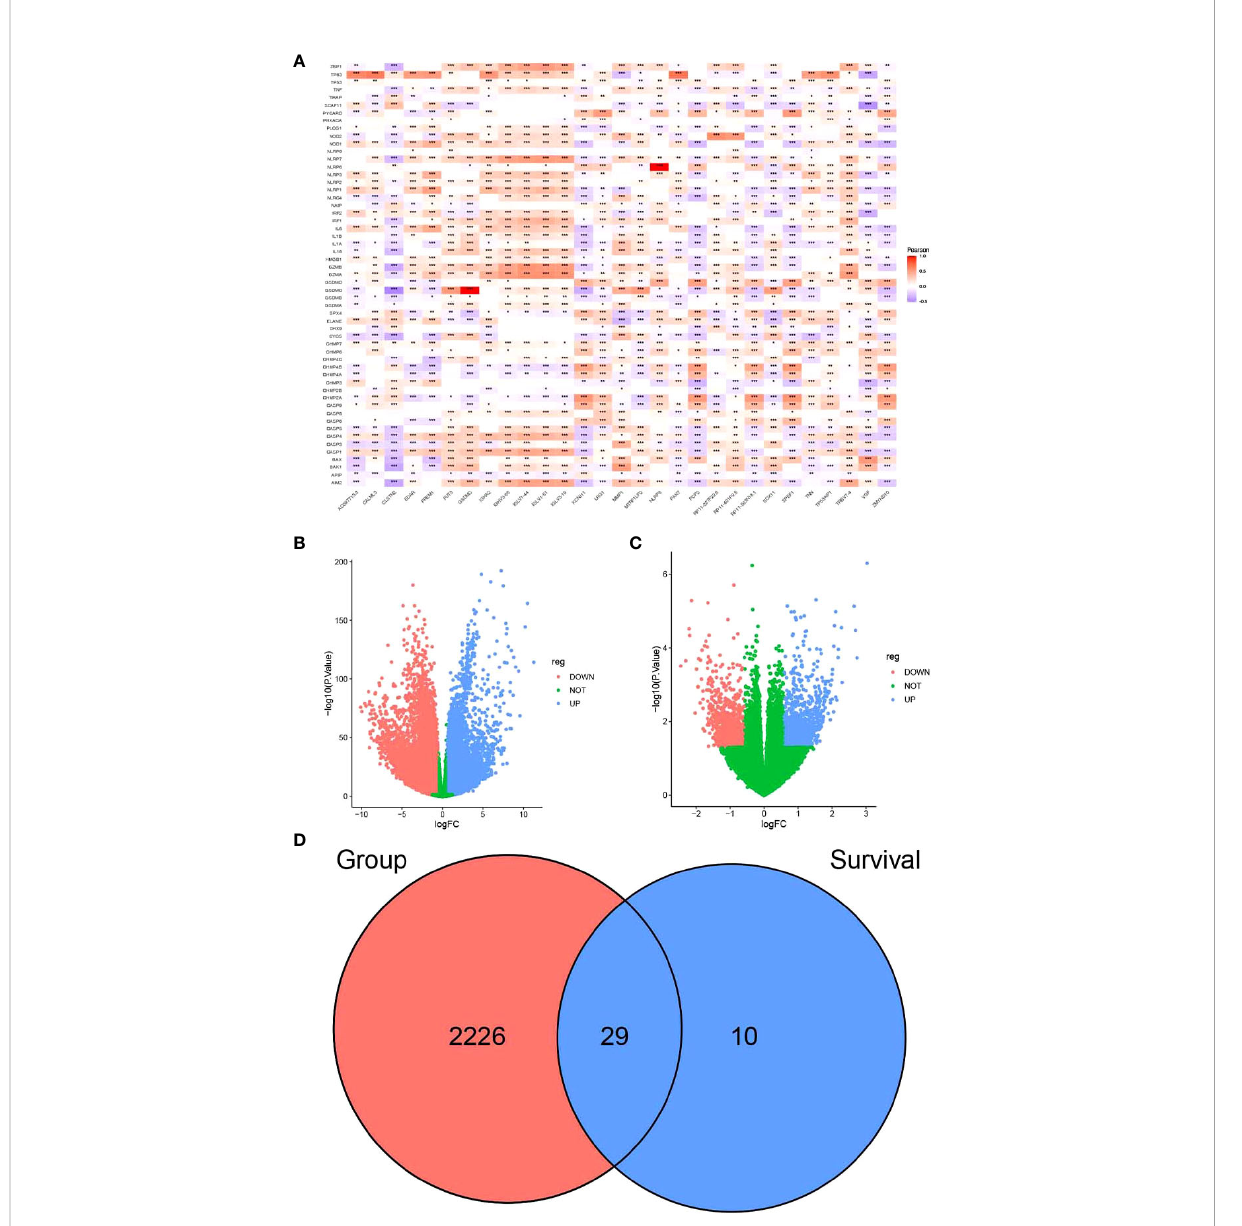
FIGURE 1 Screening of candidate genes for pyrosis. (A) Heatmap of the correlation between partial differences in the TCGA-BRCA dataset and pyroptosis genes. (B) Volcano plot depicting the results of differential analysis between tumor and normal datasets and (C) survival time. (D) Venn diagram of intersecting pyroptosis genes. * P < 0.05, ** P < 0.01, *** P <